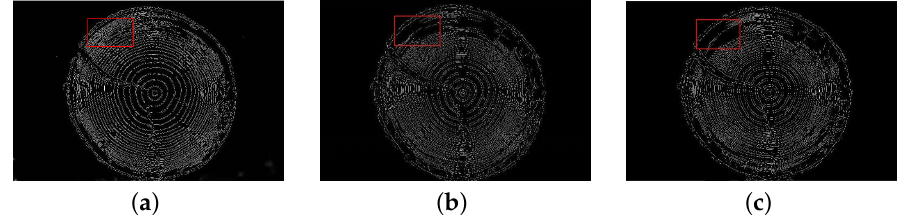
Figure 5. The effect of denoising by different methods. ( a ) Denoising by TV algorithm. ( b ) Denoising by Gaussian filtering. ( c ) Denoisng by mean filtering.